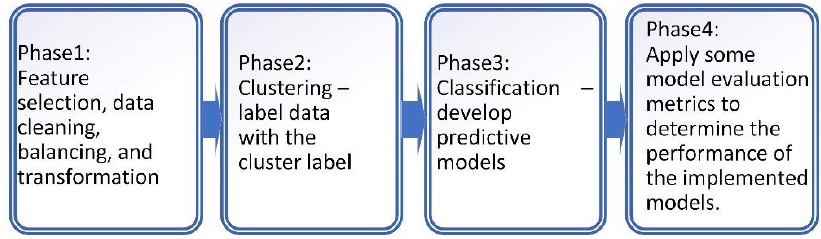
Figure 1. Prediction analysis phases.